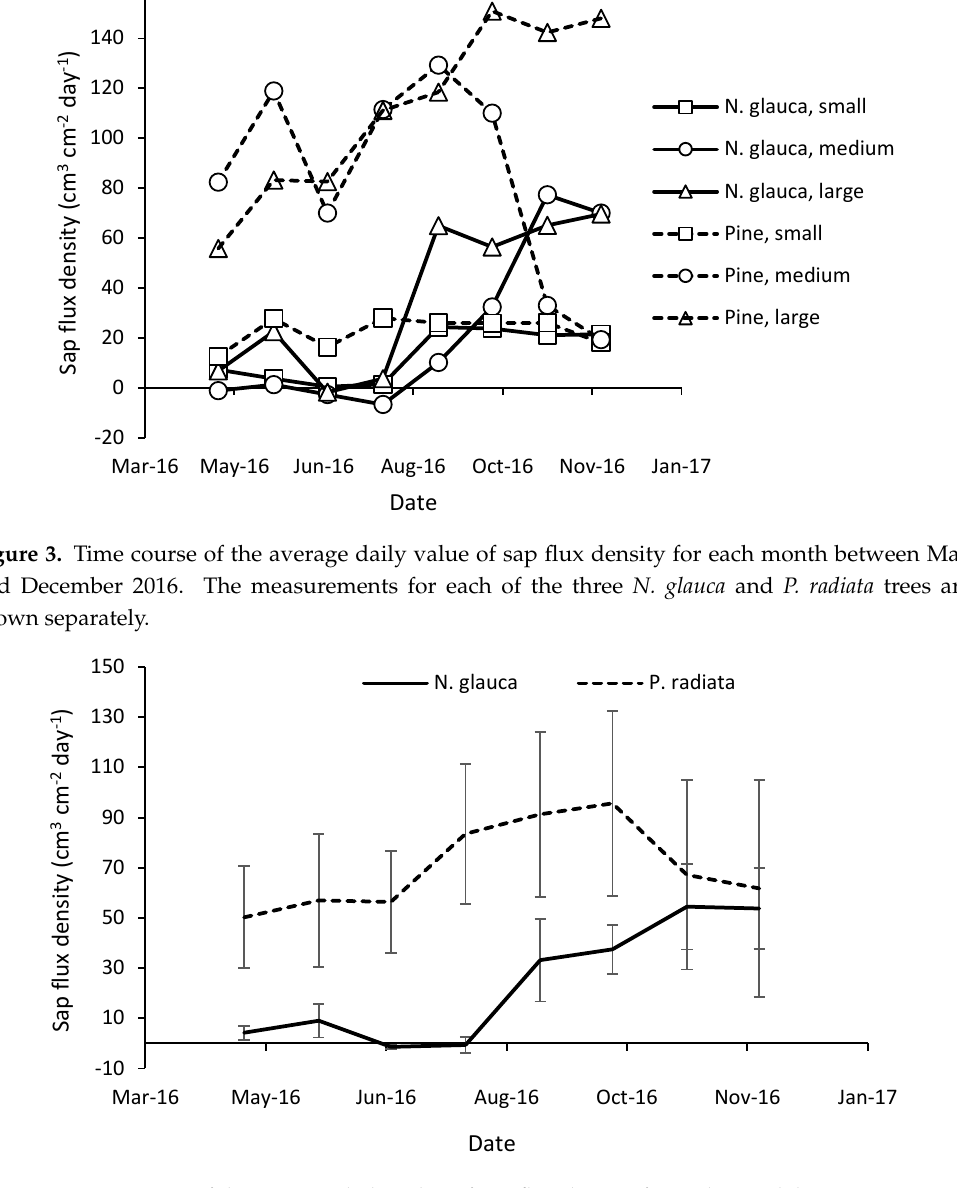
Figure 4. Time course of the average daily value of sap flux density for each month between May and December 2016 showing mean values and standard errors for N. glauca and P. radiata trees measured in the stand.